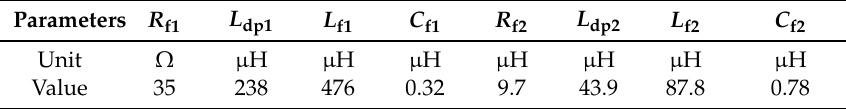
Table 3. Optimum element values of cascading input filter in Figure 6.